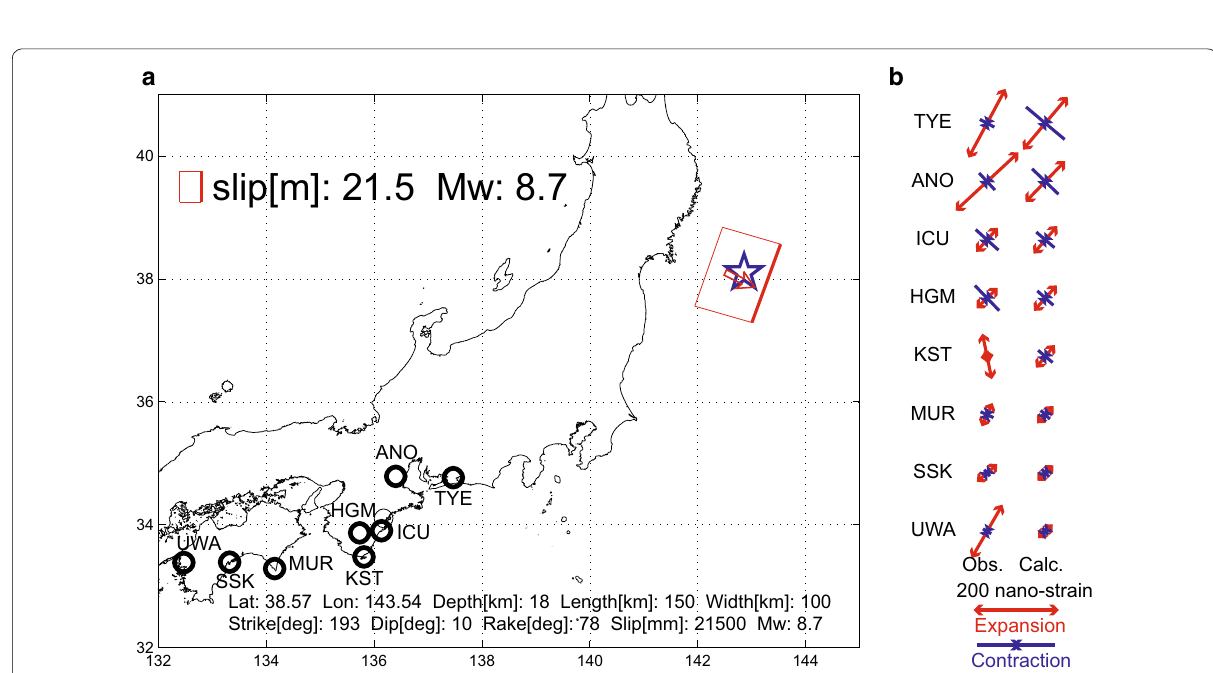
Fig. 3 a The estimated fault model for the 2011 Tohoku-Oki earthquake (red rectangle). The blue star marks the epicenter of the mainshock. The black bold circles show the borehole strainmeter sites. b Observed and calculated principal strain